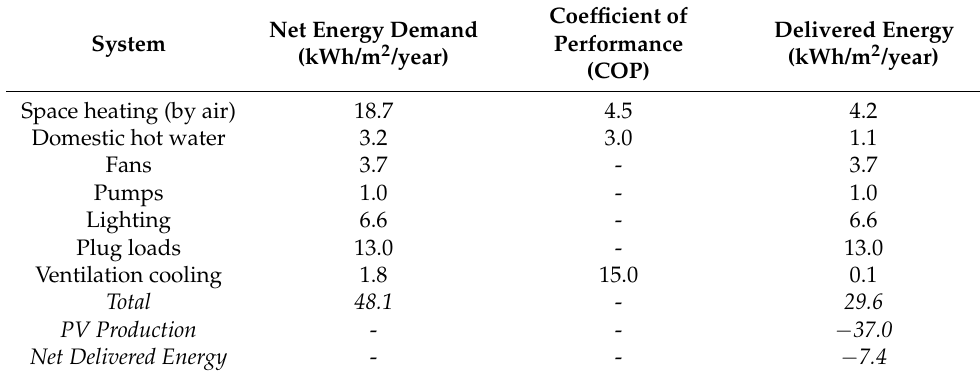
Table 2. Simulated net energy demand and delivered energy for the school.